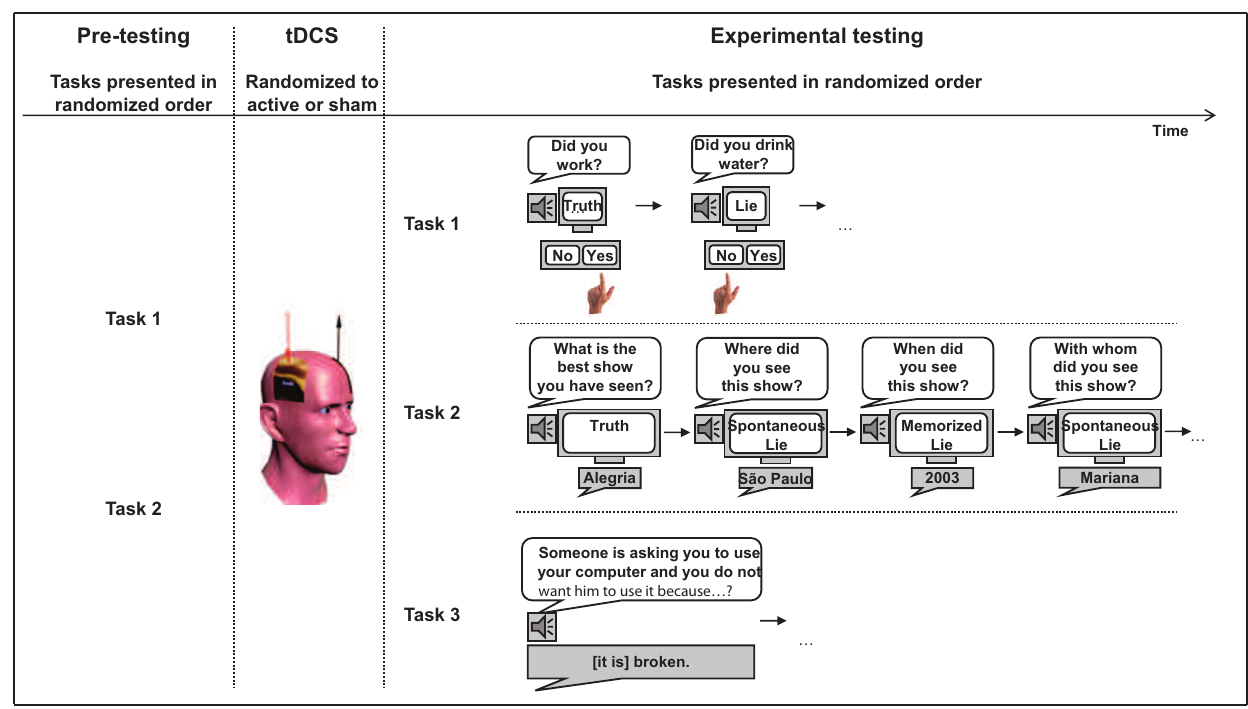
FIGURE 1 | Design of the study. Participants first performedTasks 1 and 2 (prior stimulation), they then received active or sham tDCS, and they finally performedTasks 1 and 2 again, as well as theTask